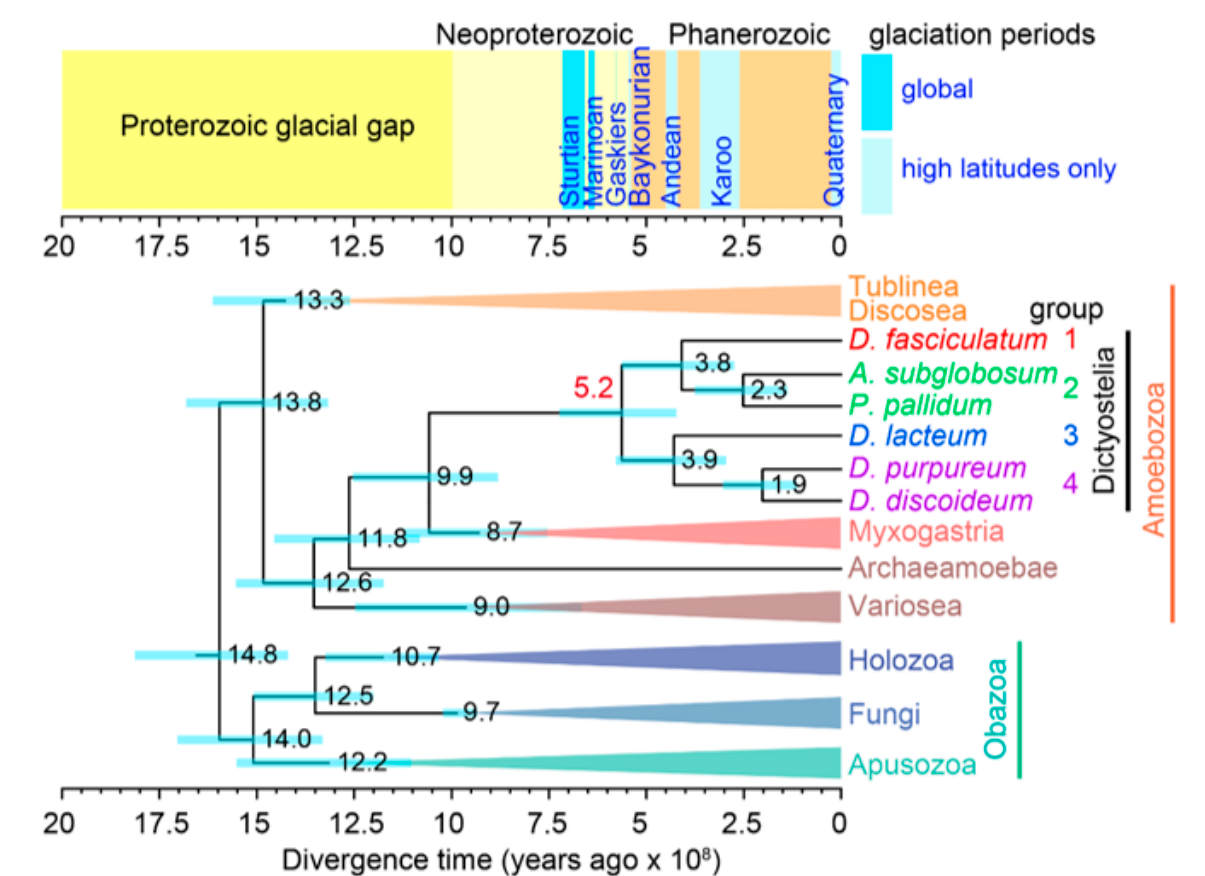
Figure 2. Time tree of Amoebozoa. A. Simplified tree of Amoebozoa with a few related groups of eukaryotes, representing the relationships of major groups. The positions of the 4 major groups of Dictyostelia are indicated. Divergence time is shown in 100 million years. Blue bars on the nodes represent Bayesian 95% Highest Posterior Density (HPD) intervals. Major global glaciation periods are shown above the tree. Redrawn from Figure 5 in [26].